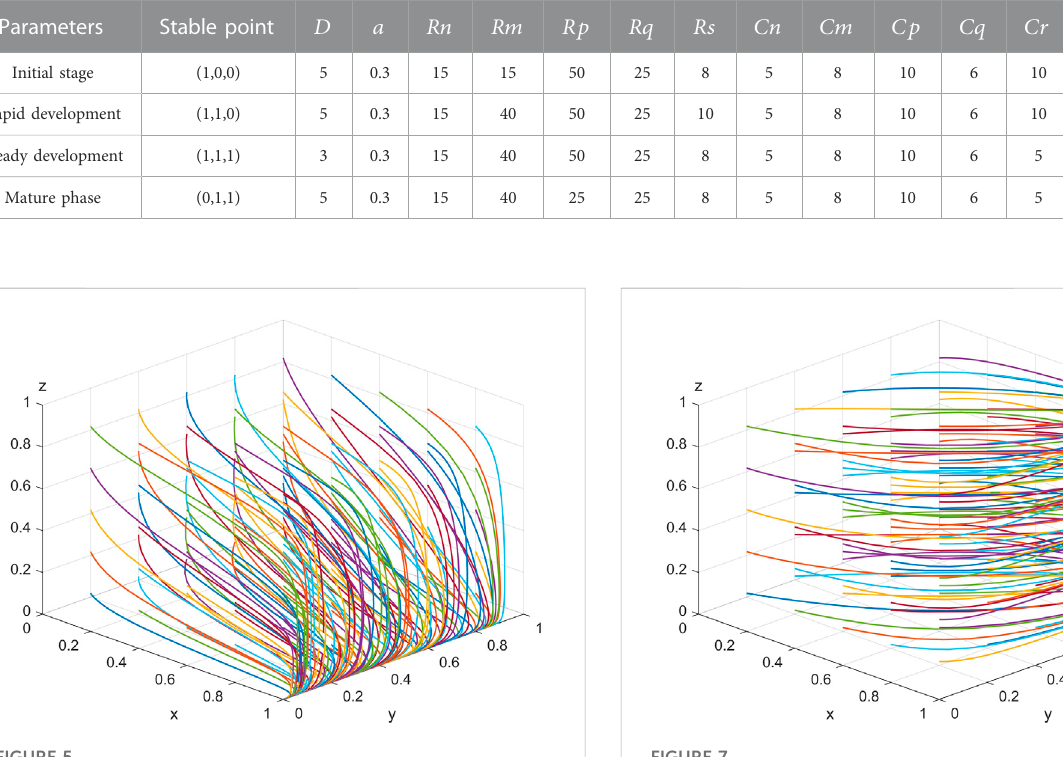
TABLE 4 Parameter values of each stage in the evolutionary game model.